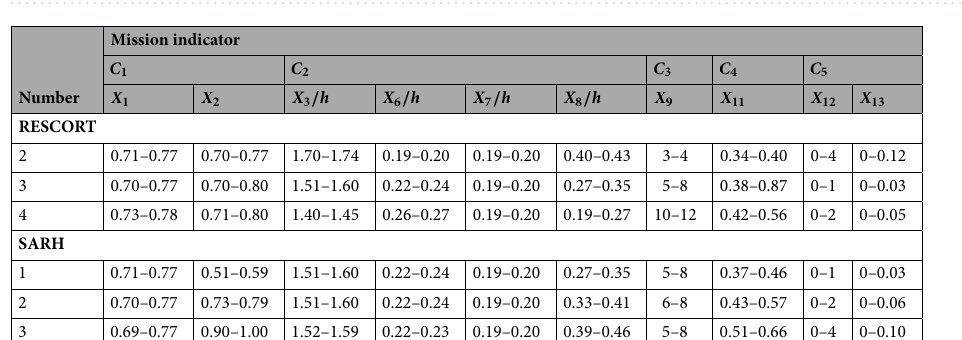
Monte Carlo method by a quasirandom sequence, overcoming the drawbacks such as the existence of “gaps” within the sample points that reduce its uniformity in distribution brought by pseudorandom sequence sampling. While the quasirandom sequence in the sobol sequence sampling is more uniform in generating random values than the pseudorandom sequence, which results in higher convergence speed and accuracy than the traditional method. Next, the main effect value S X of indicator X i is calculated according to the first-order effect index formula i (10). The main effect index values are shown in Tables 7 and 8. After calculating the main effect value S X corresponding to the mission indicator X i in each indicator matrix, i the power exponential method is used to calculate each decomposition effect layer indicator (such as the mis- sion completed indicator C 1.1 , departure time indicator C 2.1 , ……, and cost of personnel utilization C 6.3 ), and the results are obtained as shown in Table 9. Then, the weight of each decomposition effect layer indicator is calculated, and the two-by-two comparison matrix P i is given to calculate the maximum eigenvalue (cid:31) i and the eigenvector W i , as shown in Eqs. (15)–(18).